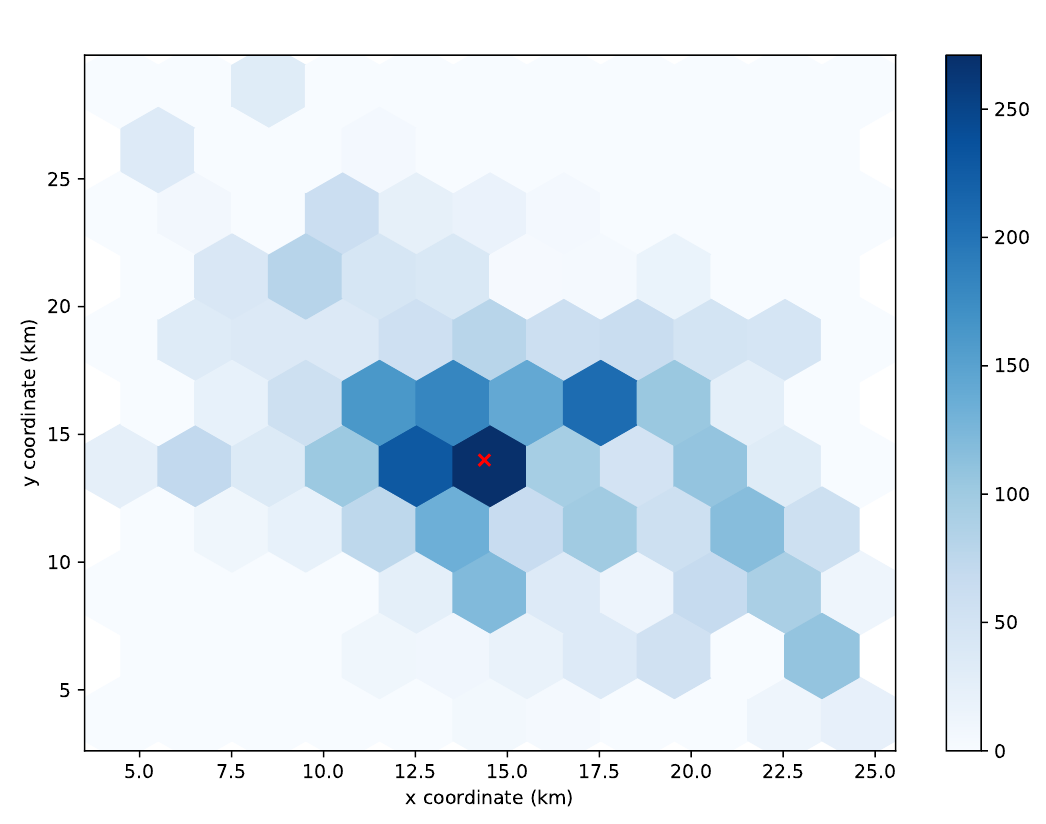
Figure 5. Distribution of 4112 UEs in the 3000th time slot of the simulation. The red cross marks the location where 1 UPF is allocated using the K-means